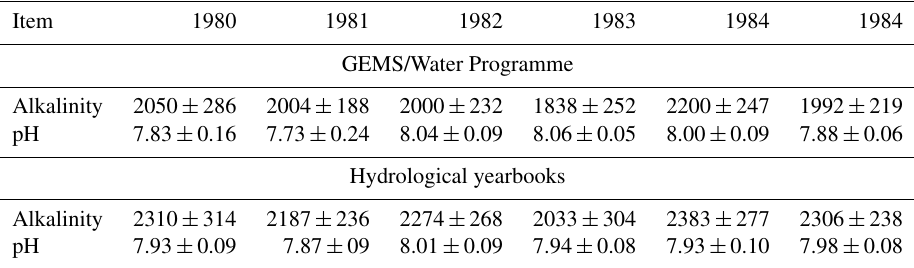
Figure 3. Spatial distribution of alkalinity (a) and p CO 2 (b) in the Yangtze River basin. The headwater region in panel (b) was not interpo- lated because of insufficient stations. Table 1. Comparison of alkalinity (µeqL − 1 ) and pH at Wuhan station between the GEMS/Water Programme results and the hydrological yearbooks, expressed as mean ± standard